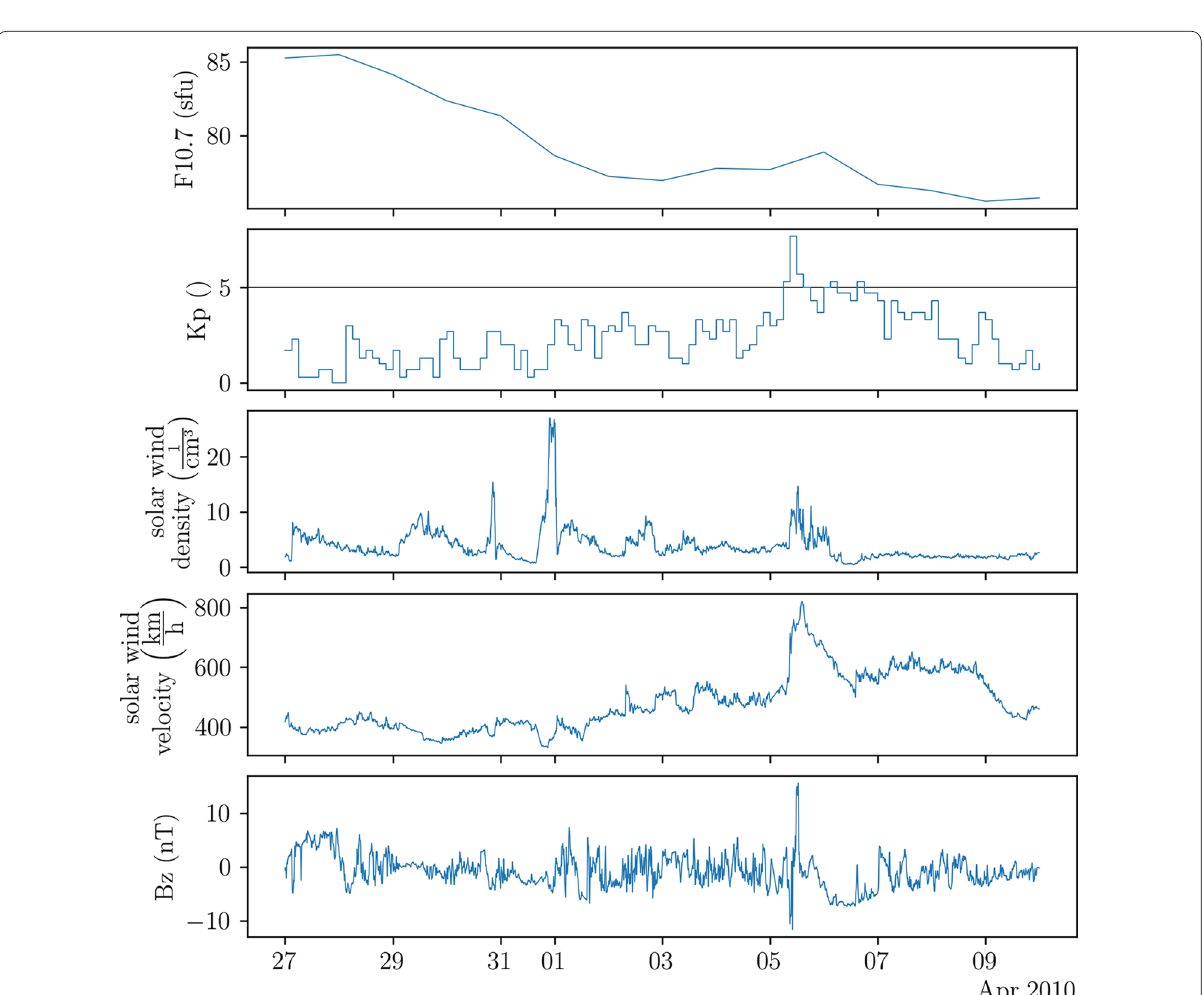
Fig. 2 External forcing time series during the period of the experiment required to run the NRLMSIS 2.0 and TIE-GCM. A Kp value greater than or equal to five is considered as storm. The main storm event is at 5th April from 6:00 to 18:00 UTC Kp index is one day and three hours, respectively. The solar wind and the z component of the interplanetary magnetic field are taken form the OMNI data set and have a 1-min